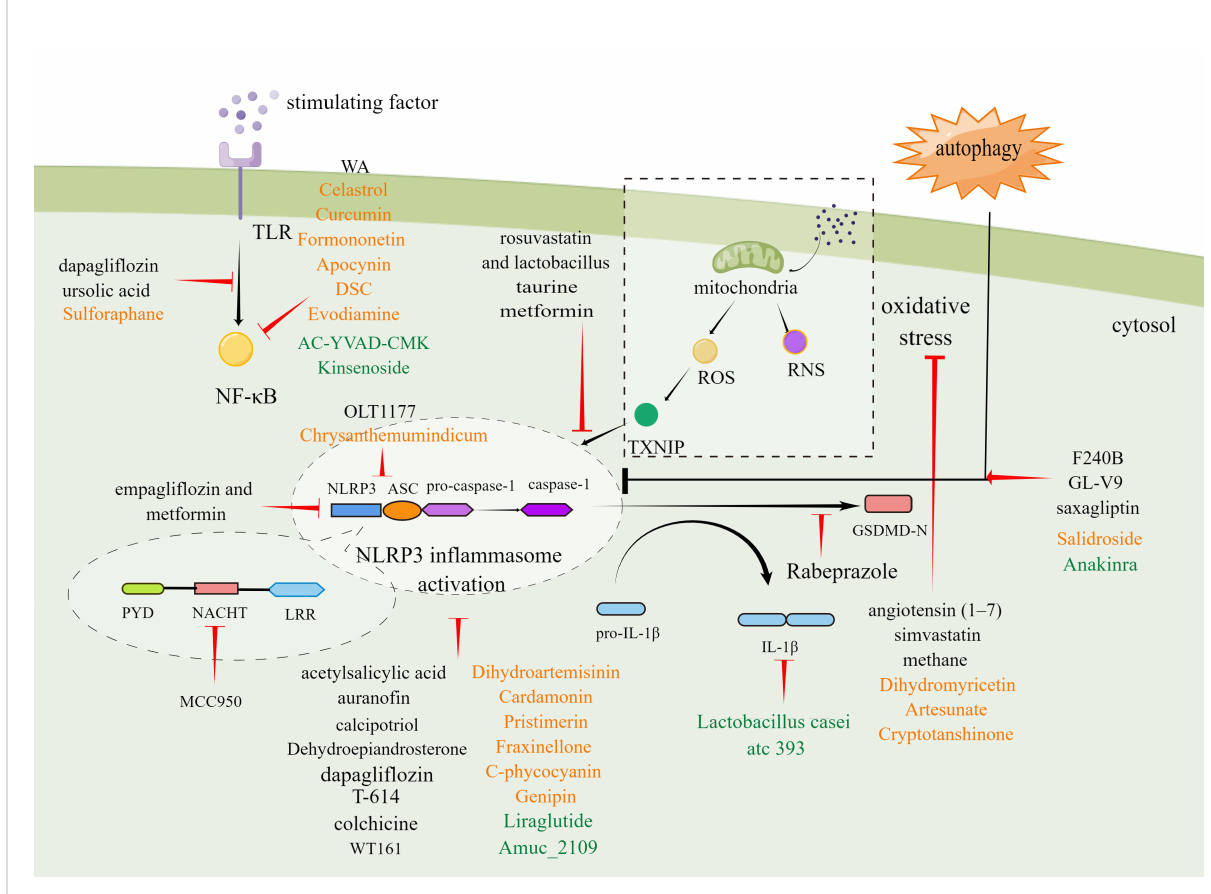
FIGURE 3 Molecular mechanism of small-molecule chemical drugs, biologics, and phytochemicals treat digestive diseases by inhibiting different steps in the NLRP3 in fl ammasome signaling pathway. Black font represents small-molecule drugs. Orange font represents phytochemicals. Green font represents biologics. By